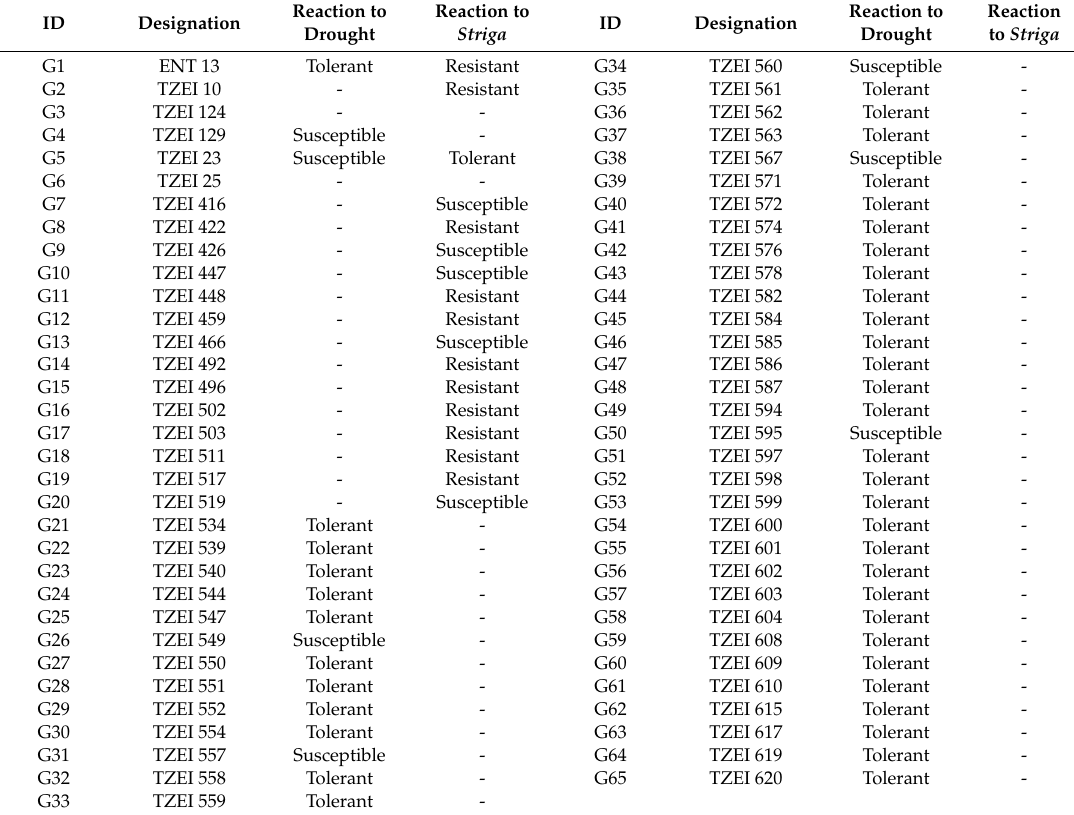
Table 1. Characteristics of inbred lines used in the